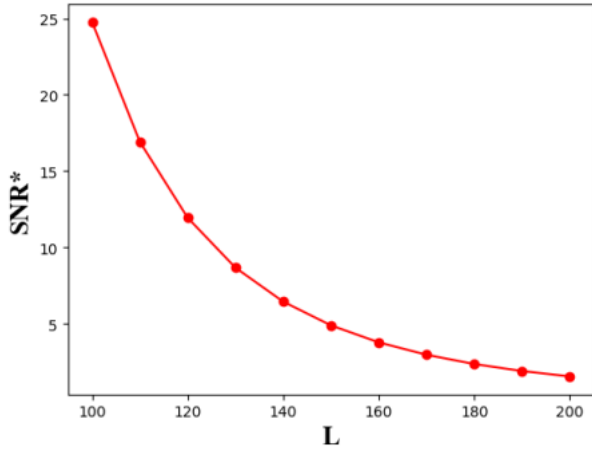
Figure 22. The relationship between line barrier length L and optimal Figure 23. The Variation deviation of barrier length of difference placement orders: S 1 , S 2 , and S 3.